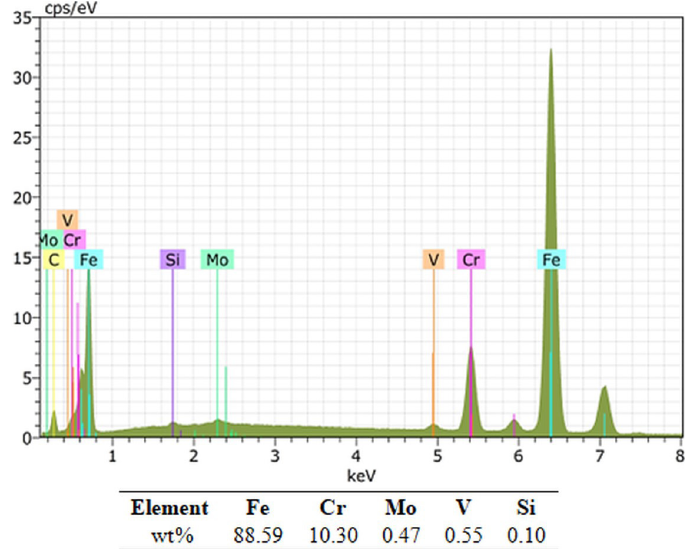
Figure 8. Spectrogram of X22CrMoV12-1 alloy in point 4.